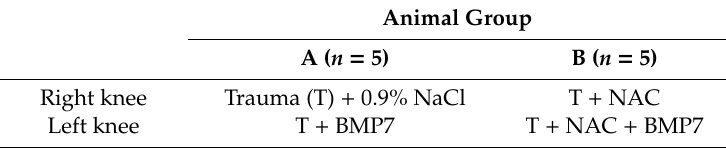
Table 1. Grouping and corresponding treatment scheme of the in vivo experiment. Animal Group A ( n = 5) B ( n = 5) Right knee Trauma (T) + 0.9% NaCl T + NAC Left knee T + BMP7 T + NAC + BMP7